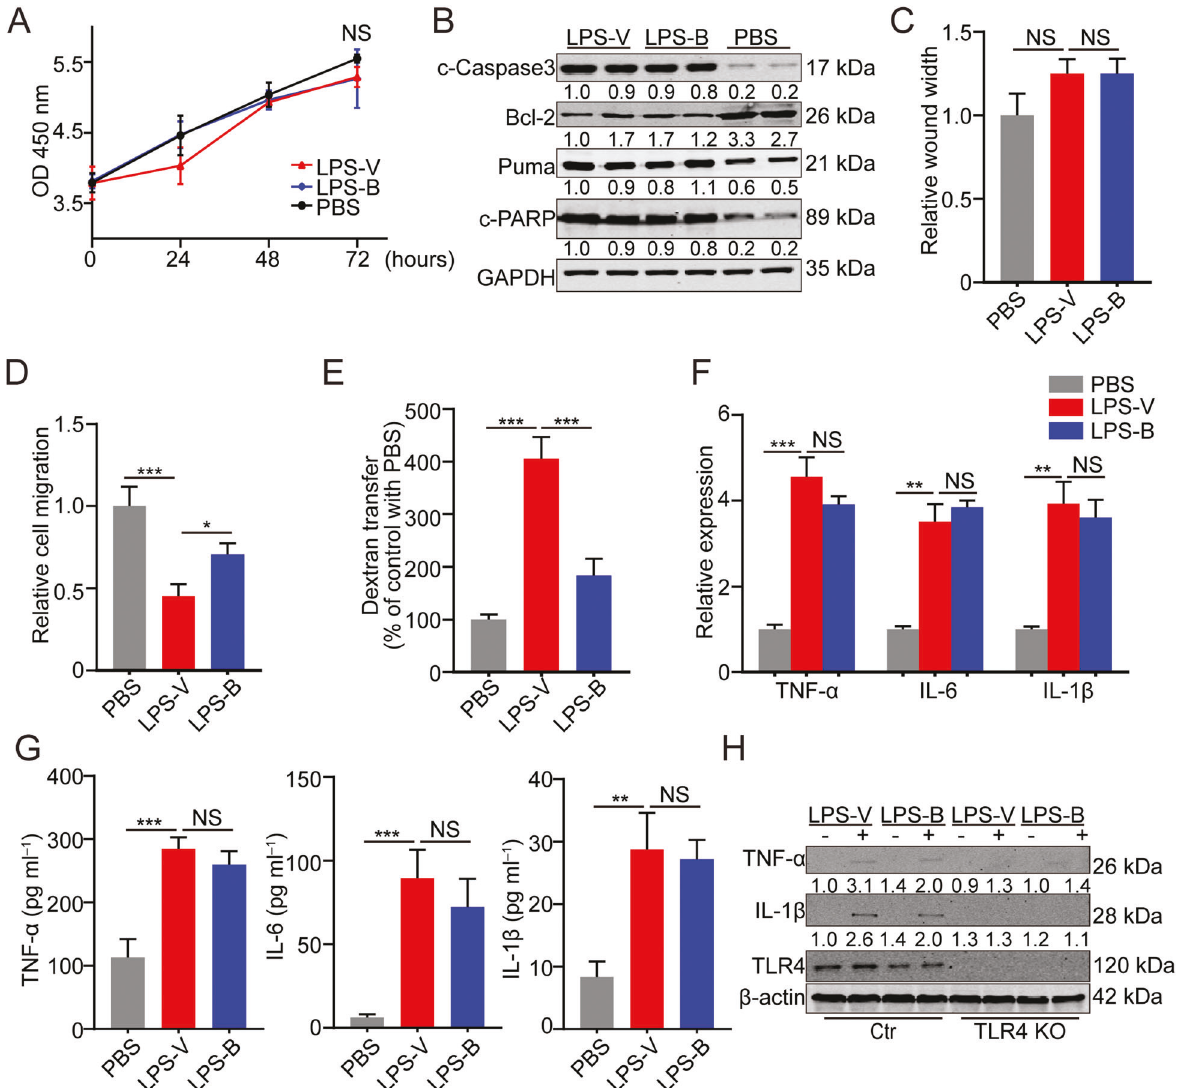
Fig. 3 LPS-V impaired the intestinal barrier function of colonic epithelial cells. A Cell proliferation was measured by CCK-8 assays in NCM460 cells with treatment of LPS-V, LPS-B or PBS. B Western blotting assays showing more apoptosis of NCM460 cells induced by LPS-V or LPS-B than ones induced by PBS. C A wound-healing assay was performed to evaluate the migration ability of NCM460 treated with LPS-V, LPS-B or PBS. D A transwell migration assay was performed to evaluate the migration ability of NCM460 treated with LPS-V, LPS-B or PBS. E A transwell assay using FITC labeled dextran 10 kDa (FD10) was performed to evaluate the paracellular permeability of NCM460 treated with LPS-V, LPS-B or PBS. F mRNA expression levels of in fl ammatory cytokines (IL-6, IL-1 β , and TNF- α ) in NCM460 treated with LPS-V, LPS-B, or PBS. G Supernatant concentration of in fl ammatory cytokines (IL-6, IL-1 β and TNF- α ) in NCM460 treated with LPS-V, LPS-B or PBS. H Western blotting assays showing that both LPS-V and LPS-B increased the IL-1 β and TNF- α expression that was blocked by TLR4 knockout. All data are expressed as mean ± SD. NS denotes no signi fi cation. * P < 0.05; ** P < 0.01; *** P <